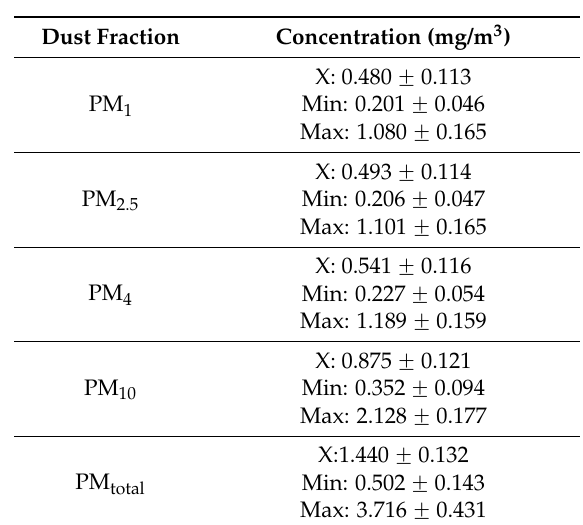
Table 4. Airborne dust concentration in poultry